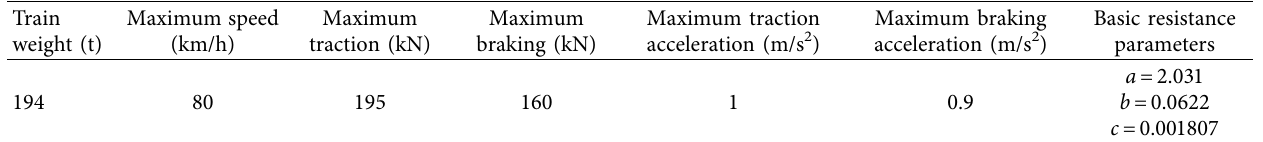
Table 2: Te train operation parameters.